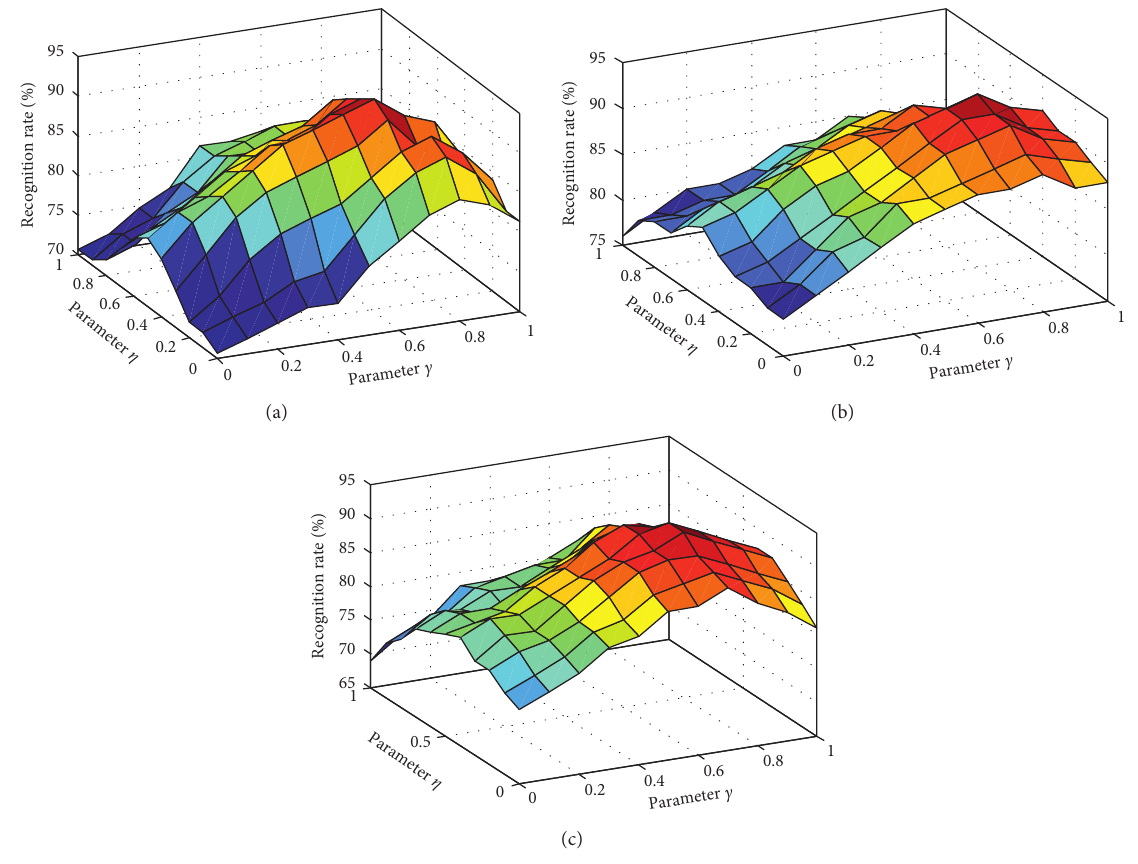
Figure 4: Recognition rate with different parameters c and η . (a) Experiment result based on Yale-B face database. (b) Experiment result based on ORL face database. (c) Experiment result based on UMIST face